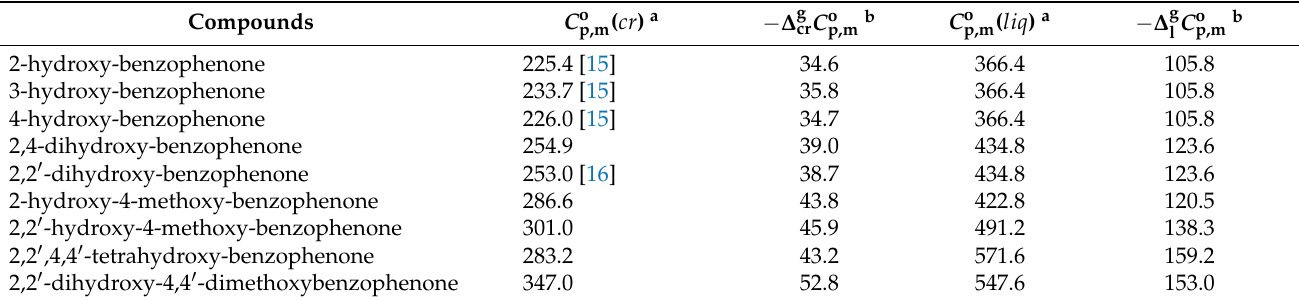
Table 3. Compilation of data on molar heat capacities C o p,m (cr or liq) and heat capacity differences at T = 298.15 K (in J · K − 1 · mol − 1